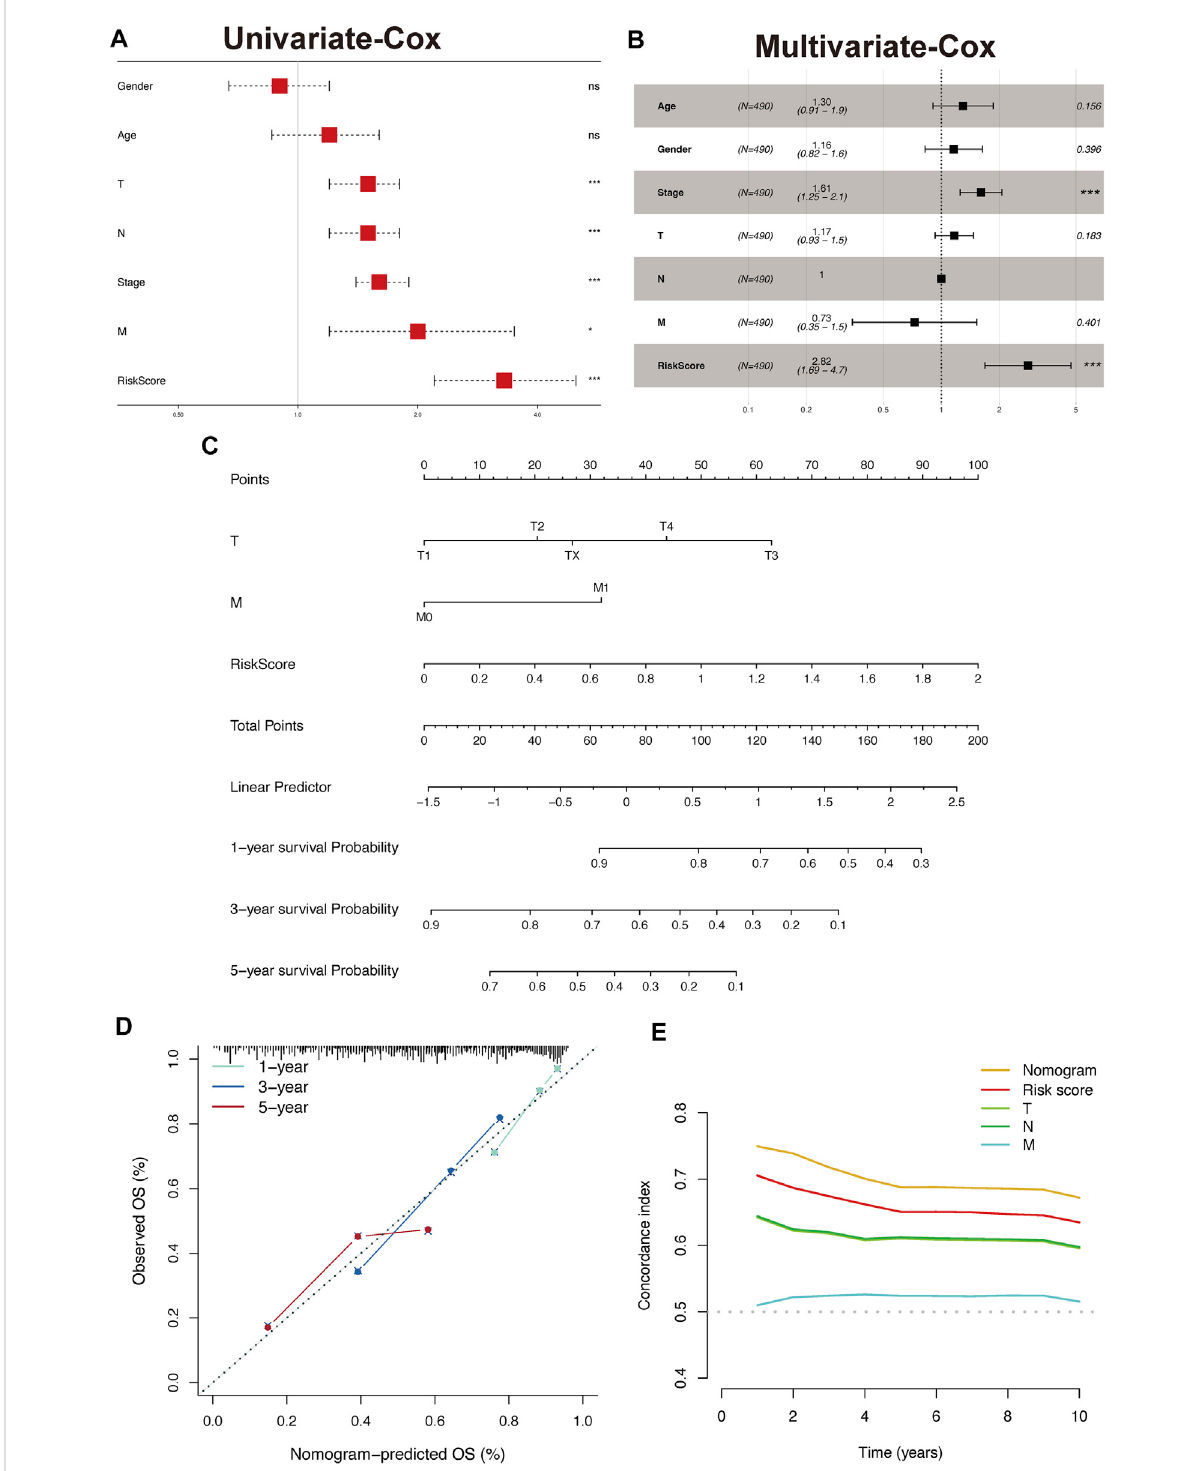
FIGURE 12 Construct and validate the nomogram model. (A,B) Univariate (A) and multivariate (B) analyses were performed using Cox regression of the TCGA-LUAD cohort. (C) Nomogram based on TPR signature and Stage in TCGA-LUAD. (D) Calibration of a nomogram predicting 1-, 3-, and 5-year OS. (E) Distributions of concordance index values in a nomogram and relevant clinical